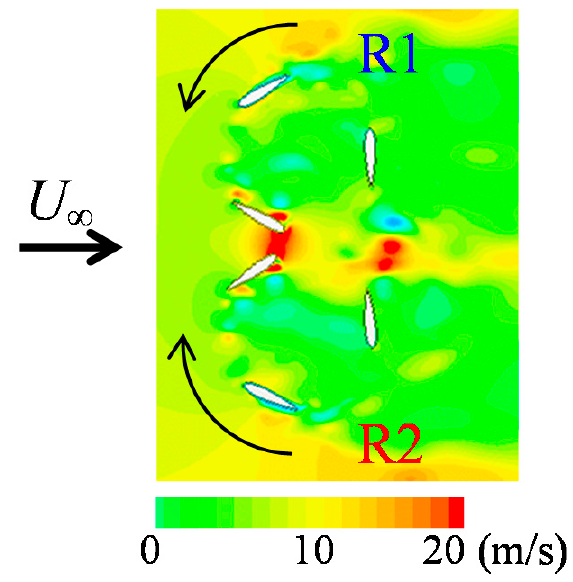
Figure 20. Color contour of flow velocity ( x -direction component) around rotors in CD layout with gap / D = 0.2, where increase in flow speed by phase synchronization of two rotors is demonstrated.